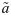
Sensor signal characteristics vs. size of functionalized area.The expected normalized signal as a function of a˜ or A
0 for a constant surface coverage. ℓ=1,R˜=0.01.